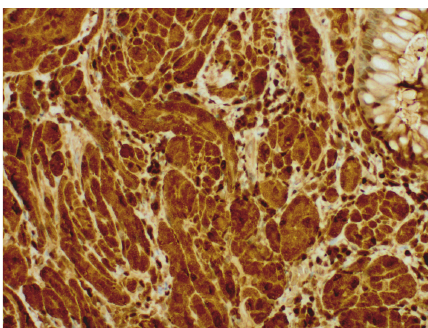
Figure 1: The 4mm firm nodule visualized in rectum.